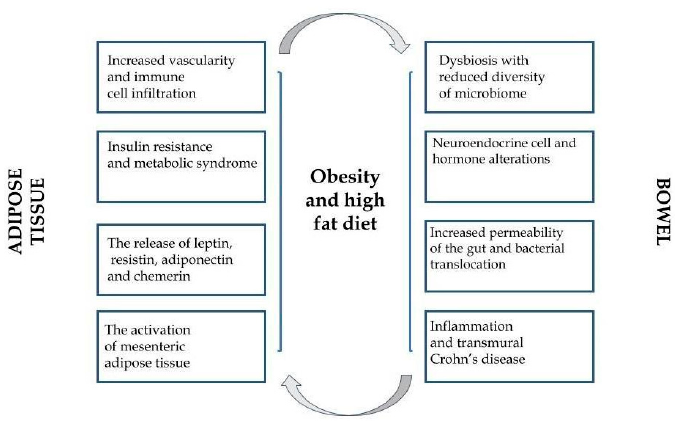
Figure 1. The interactions between obesity, adipose tissue, and inflammatory bowel